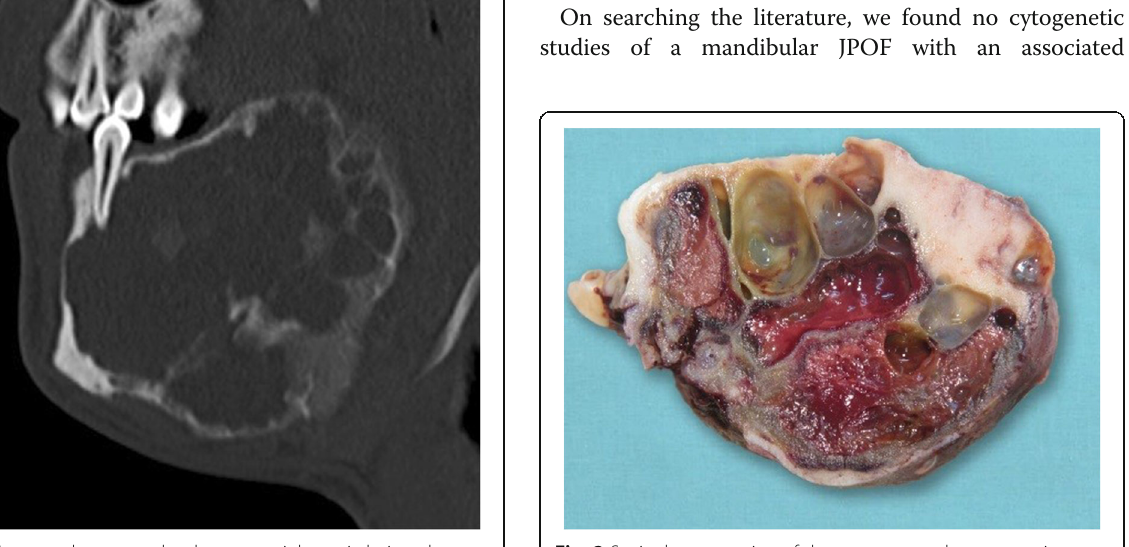
Fig. 1 Computed tomography shows a mainly cystic lesion; the tumour proper is the solid area in the labial aspect of the lower part (arrow)